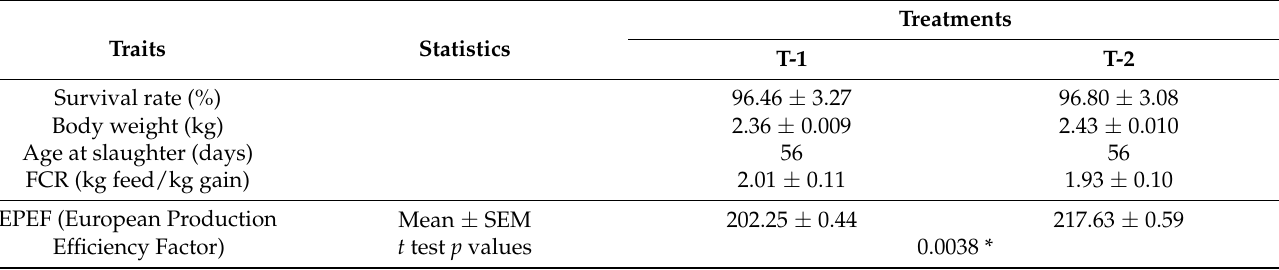
Table 5. European Production Efficiency